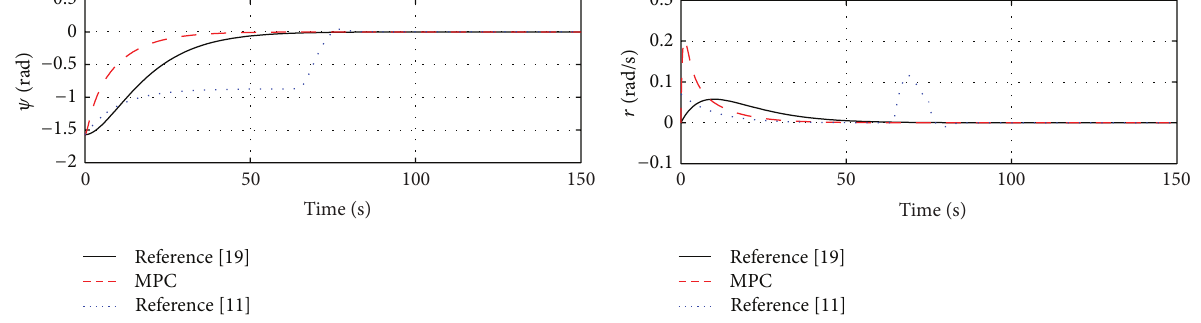
Figure 3: Trajectory of 𝜓 and 𝑟 .